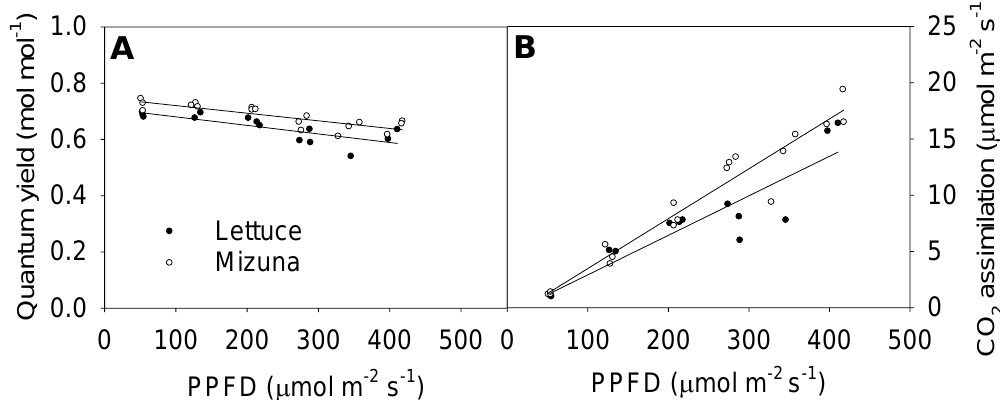
Figure 5. ( A ) Quantum yield of photosystem II and ( B ) net CO 2 assimilation rate of mizuna ( Brassica rapa var. japonica ) and lettuce ( Lactuca sativa ‘Green Salad Bowl’) plants grown and measured at six photosynthetic photon flux densities (PPFD s ). Data were collected a day before the harvesting (26 and 27 days for mizuna and lettuce, respectively). Lines show the results from multiple regression analysis, which indicated no significant species × PPFD interaction for quantum yield ( R 2 = 0.72, interaction P = 0.62), but significant effects of PPFD and species (both P < 0.0001). For CO 2 assimilation rate, there was a weak species × PPFD interaction effect ( R 2 = 0.91, interaction P = 0.08).